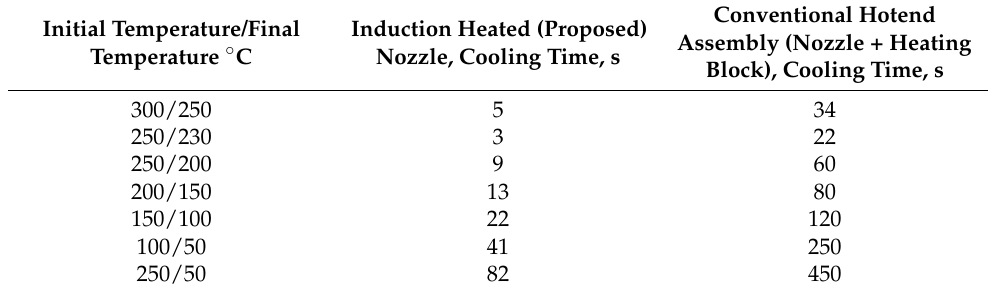
Table 5. Cooling rate characteristics of the induction heated (proposed) nozzle and the conventional hotend assembly (nozzle+heating block) at the extrusion speed of 0 mm/s. Conventional Hotend Initial Temperature/Final Induction Heated (Proposed) Assembly (Nozzle + Heating Temperature ◦ C Nozzle, Cooling Time, s Block), Cooling Time,